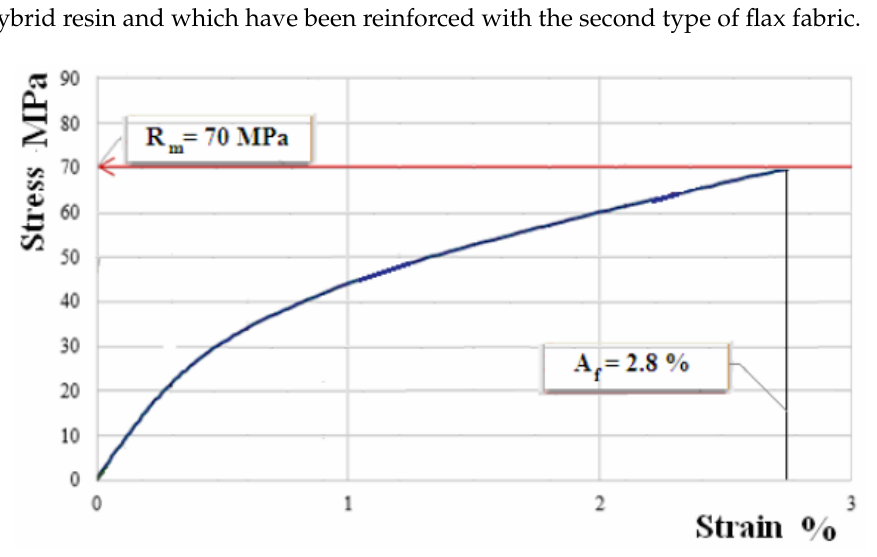
Figure 10. Characteristic curve for sample of composite material with matrix of hybrid resin of type 1, reinforced with the second type of